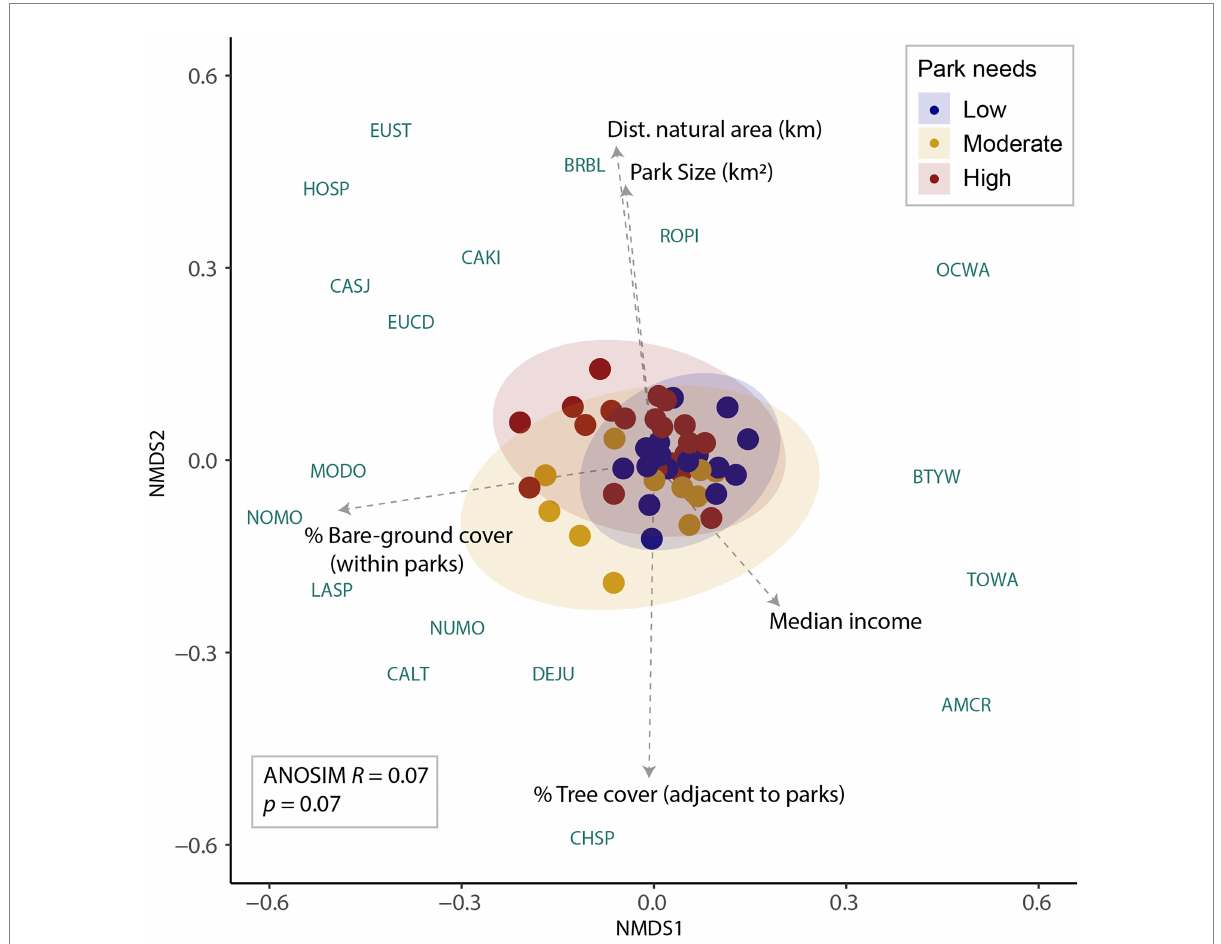
FIGURE 4 2-D non-metric, multidimensional scaling ordination (NMDS) plot of avian species composition ( N -mixture estimated abundance per species) within parks situated across a ‘park needs’ assessment gradient in Greater Los Angeles (LA). The ordination successfully converged with a stress value of 0.22. The ellipses are the bivariate confidence interval assuming a Student’s- t distribution and characterize the potential of the avian community within a park needs assessment categories. The dotted lines represent vectors of environmental variables that were significantly associated with the ordination scores. Axis one is thus weakly positively associated with median income and negatively with bare ground cover within parks. Axis two is correlated with a positive distance to the nearest natural area (km), and park size (km 2 ) and negatively with the surrounding cover of trees in the urban landscapes adjacent to parks. The four-letter codes are the plotted Bray–Curtis dissimilarity distances of 18 avian species (see Table 1) that were significantly correlated with axes one or